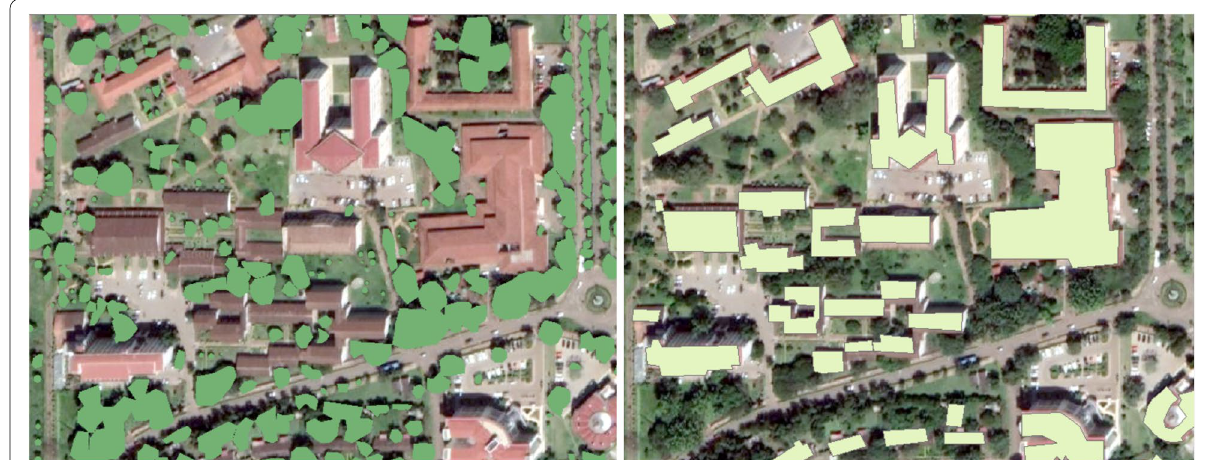
Fig. 6 Detailed illustrations of a section of the study area indicating how tree canopies (left) and buildings (right) were extracted from Google Earth ® image. Other features (i.e. roads, parking lots, bare soils, and grass cover) was obtained in a similar way